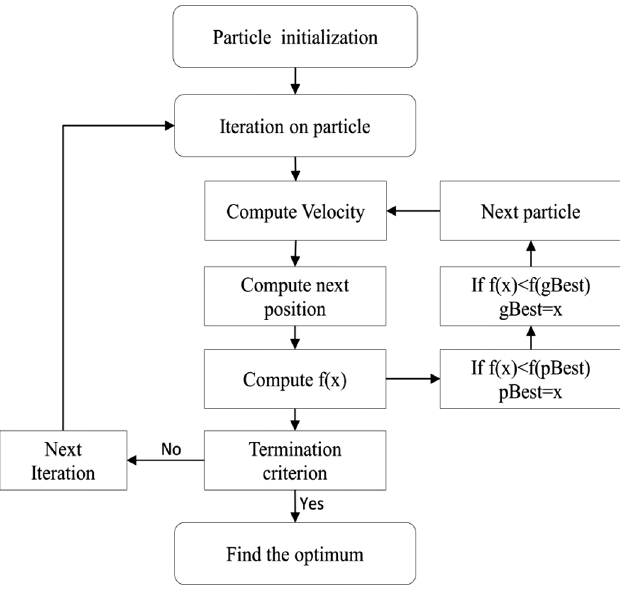
Fig. 2. Flowchart of the classic PSO